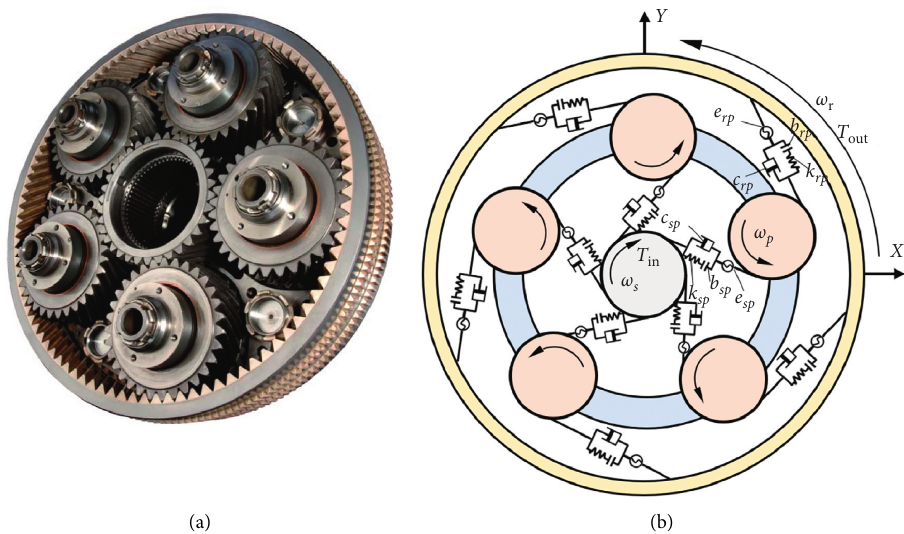
Figure 3: Dynamic model of star gearing system GTF gearbox. (a) Physical model, (b) dynamic